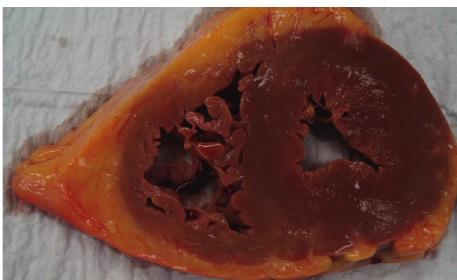
Figure 4: Autopsy of cardiac muscle with increased subpericardial fat asymmetrically concentrated more towards the right ventricle compared to the left ventricle.